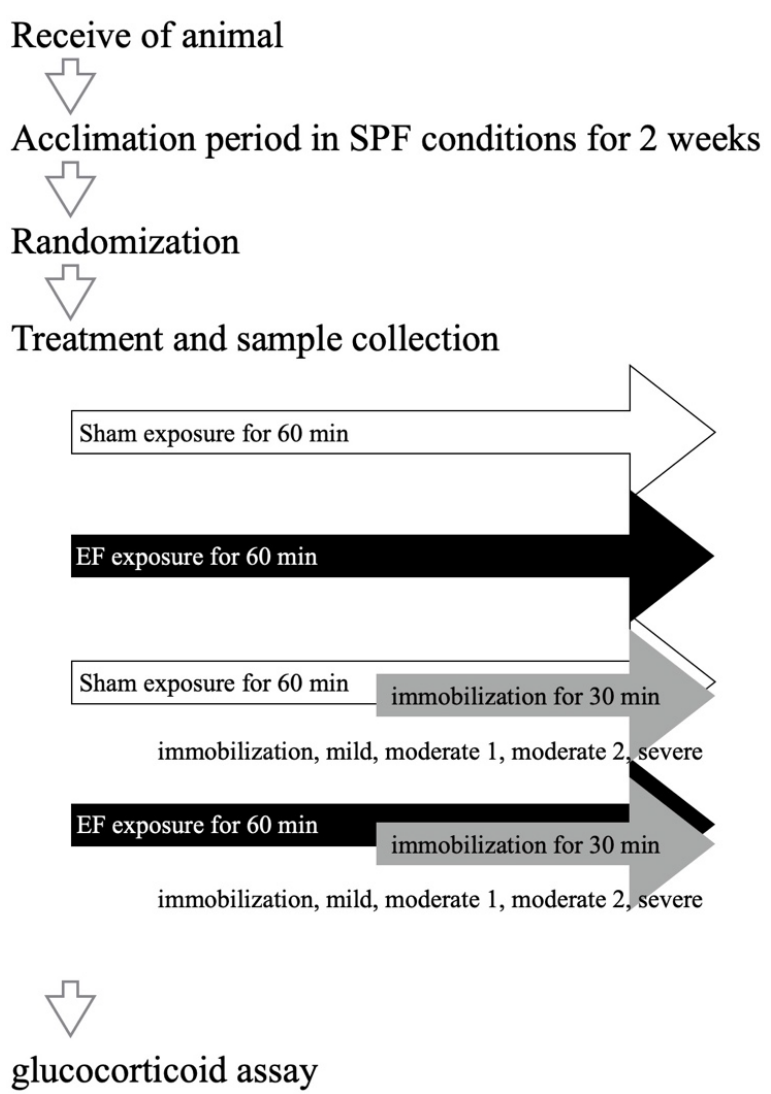
Figure 3. Experimental design to assess EF suppression of stress response according to immobilization degree. We divided 64 mice into eight groups: control (stress( − )/EF( − ), n = 8), EF-alone (stress( − )/EF(+), n = 8), immobilization-alone (stress(+)/EF( − ), n = 24), and cotreatment (stress(+)/EF(+), n = 24) groups. Three stress degrees were arranged according to volume for mouse immobilization (Figure 3). The volumes for moderate, mild, and severe stress degrees were 40, 48, and 32 mL, respectively.